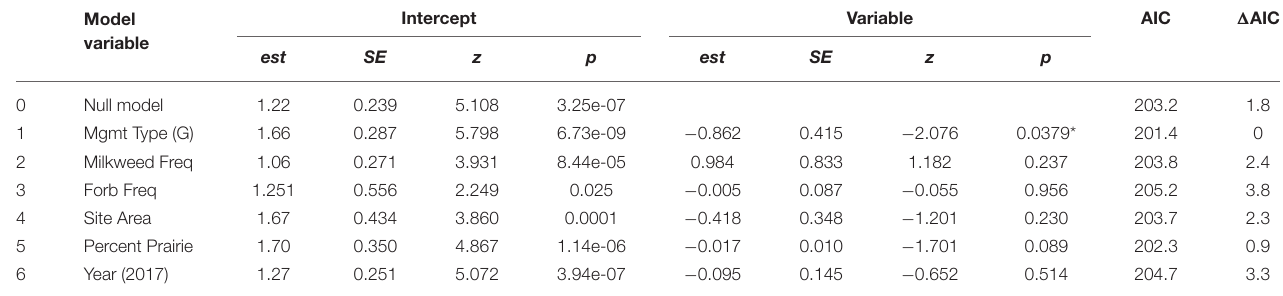
TABLE 3 | Univariate models showing the effects of predictor variables of interest on monarch abundance. Model